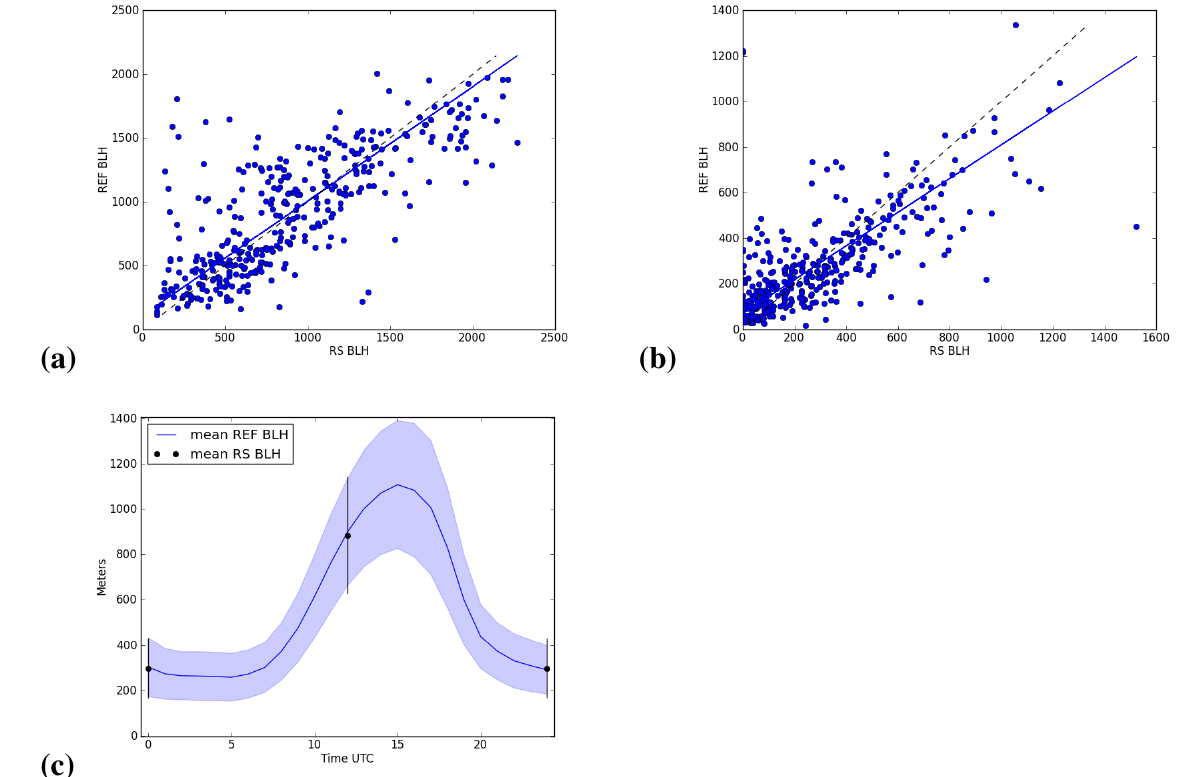
Fig. 8. (a) and (b) : Correlation between observed (noted RS) and simulated BLH at Trappes for the REF simulation for 1yr (August 2010–July 2011) for 12h forecast (12:00UTC sounding) and 24h forecast (00:00UTC sounding). The regression is indicated by the continuous line. (c) : Diurnal cycle over the year of the BLH at Trappes predicted by REF (blue line for the mean and blue area for the standard deviation) with the observed values marked by dots for the mean and by bars for the standard deviation. Table 5. Statistical scores of the BLH at Trappes from observation (mean and standard deviation, noted STD DEV) and from the REF simulation over 1yr (August 2010–July